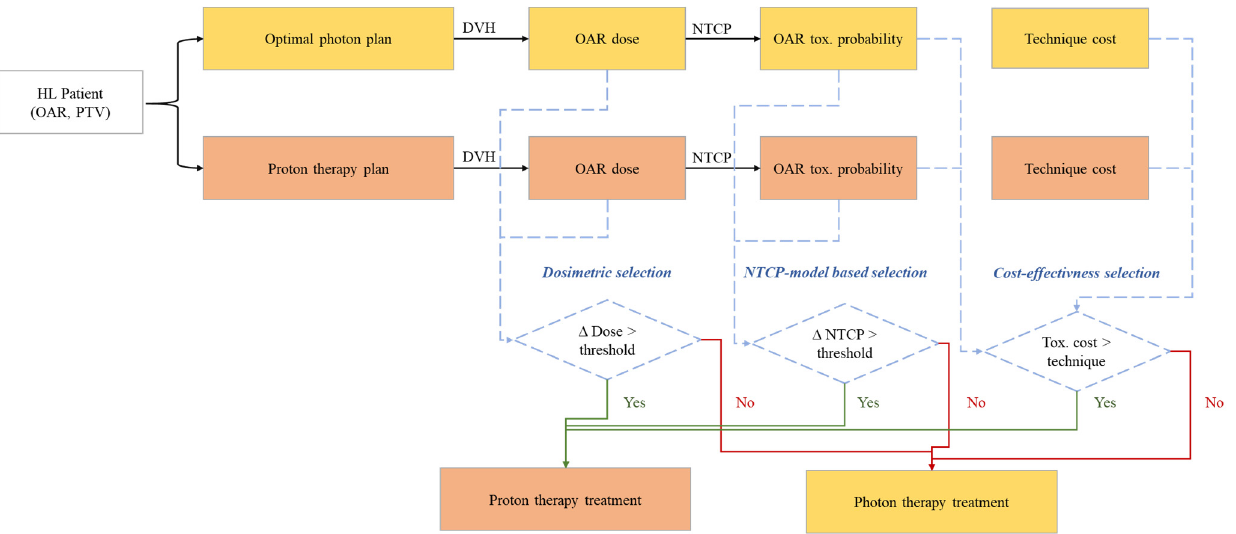
Figure 1. Current approaches to select patients for proton therapy. All selection processes rely on a dosimetric comparison between optimal photon (usually VMAT) and proton therapy plans. Depending on the methods, patients could be directly selected based on the dosimetric comparison (“dosimetric selection”), after evaluation of predicted toxicity reduction with proton therapy based on NTCP models (“NTCP model-based selection”); or after cost-effectiveness calculations (“cost- effectiveness selection”). HL: Hodgkin lymphoma; OAR: organ-at-risk; PTV: planned target volume; DVH: dose-volume histogram; NTCP: normal tissue complication probability; ∆ : difference.